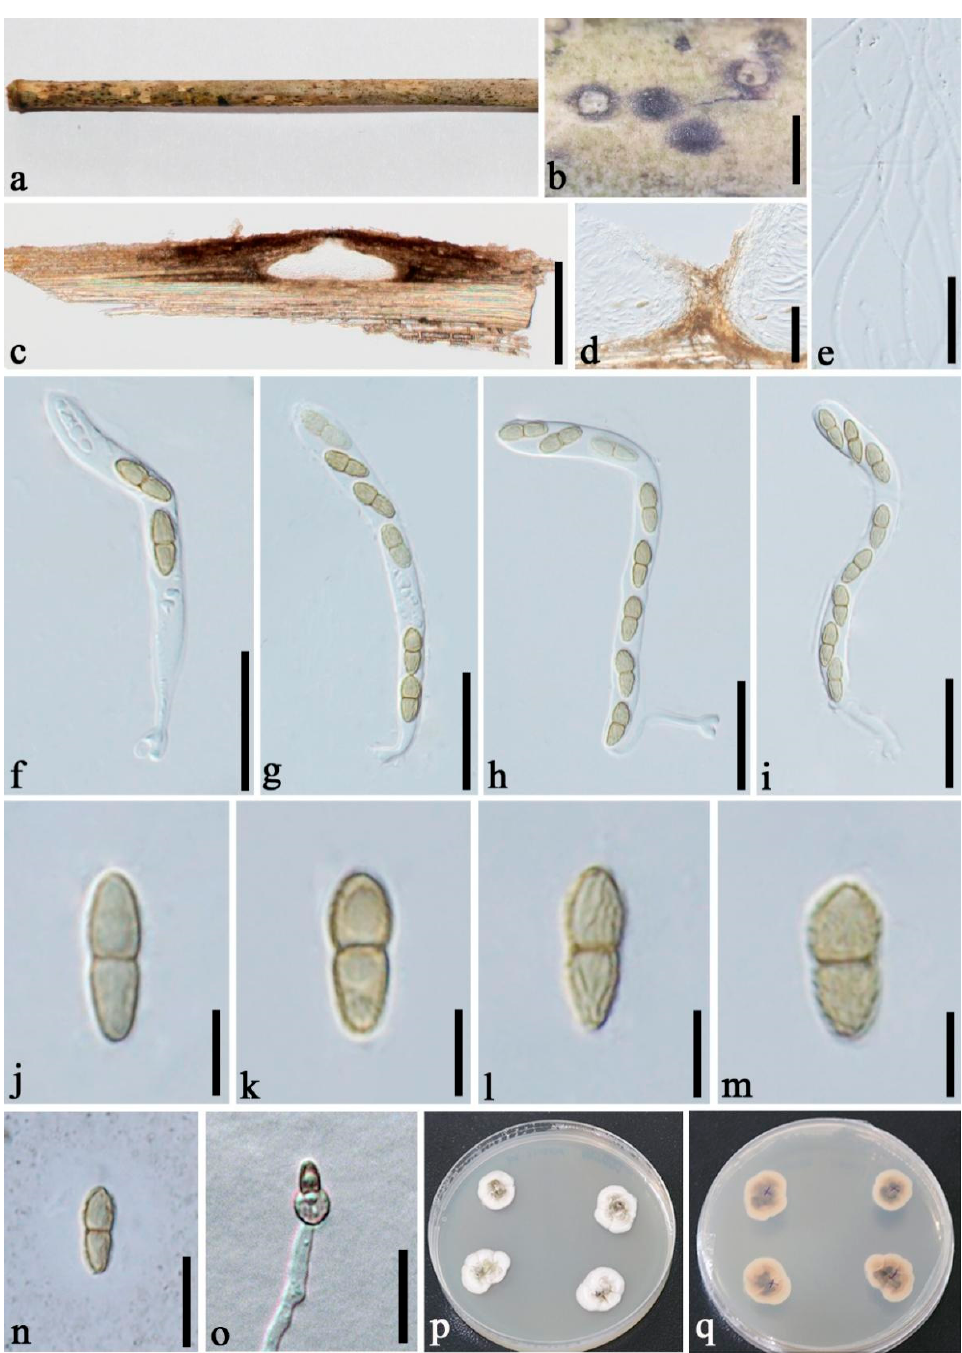
nucleotide substitutions per site per branch.